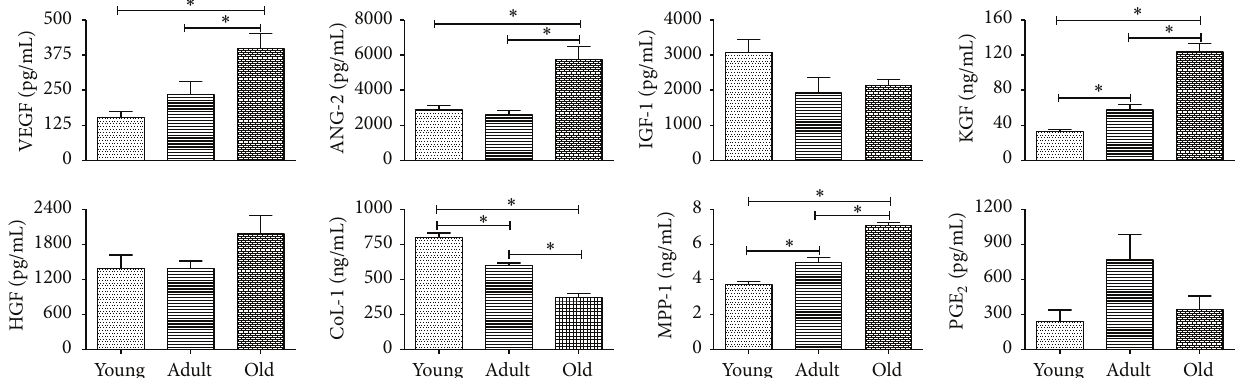
Figure 8: acd-MSCs secretion profile. The secretion levels of MSC paracrine factors (VEGF, ANG-2, IGF-1, KGF, HGF, CoL-1, MMP-1, and PGE 2 ) from different aged donors were analyzed by ELISA. Data are mean ± SEM ( 𝑛 = 8 ). ANOVA ∗ : young versus adult versus old. Only significant statistical values are